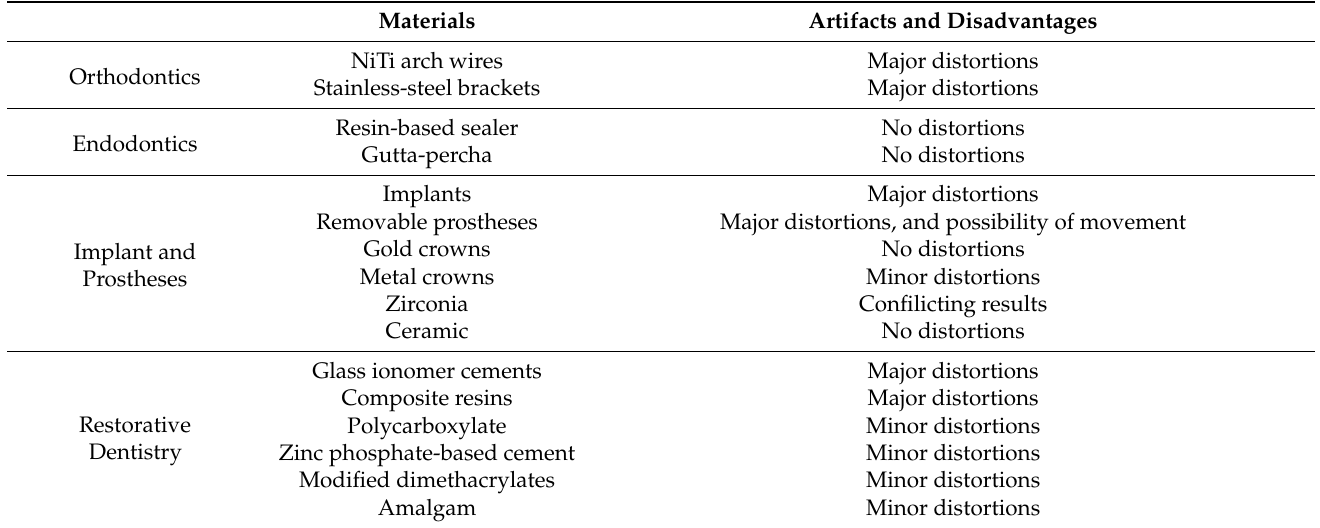
Table 1. Dental materials that generate